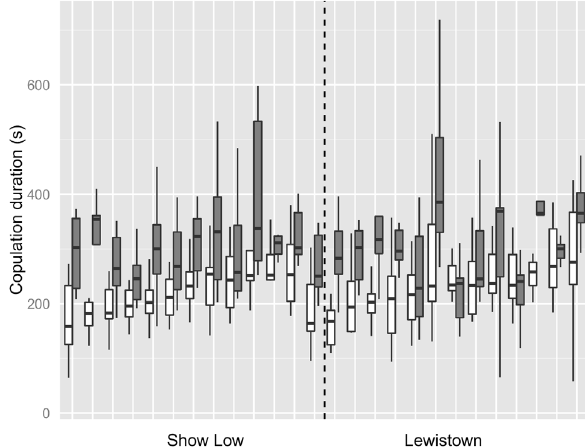
Figure 1. Boxplot showing the variation in copulation duration of males from 13 isofemale lines from each of two populations (Show Low and Lewistown), both when exposed to a male rival prior to copulation (filled boxes) or not exposed to rivals (hollow boxes). Median, interquartile range and total range are shown by the horizontal lines, boxes and whiskers